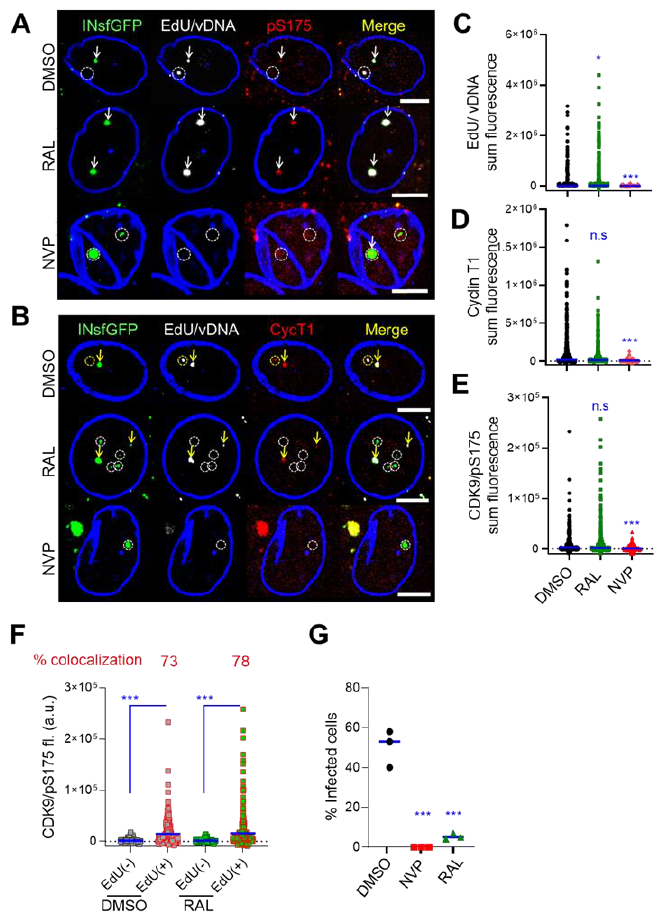
Figure 6. Cellular transcription machinery associates with nuclear HIV-1 clusters. MDMs were pretreated with Vpx( + ) SIV-VLPs and infected with VSV-G-pseudotyped HIV-1 labeled with INsfGFP by spinoculation (MOI of 2). Unbound virus was washed away, EdU (5 µ M) was added, and MDMs were cultured for 72 h. ( A – E ) As indicated, infections were carried out in the presence of nevirapine (NVP, 10 µ M) or raltegravir (RAL, 20 µ M). Cells were fixed and stained for EdU / vDNA and the components of the P-TEFb transcription complex, Cyclin T1 (CycT1) and CDK9 / pS175 (pS175). ( A , B ) Images of MDM nuclei showing INsfGFP fluorescence (green), EdU / vDNA (white), and pS175 ( A ) or CycT1 ( B ) staining (red). Arrows in ( A ) and ( B ) point to the IN spots colocalized with EdU and P-TEFb complex; dashed circles indicate IN clusters that do not colocalize with EdU, P-TEFb, or both. ( C – E ) Analysis of nuclear INsfGFP puncta colocalization with EdU ( C ), Cyclin T1 ( D ), and CDK9 / pS175 ( E ). ( F ) Analysis of CDK9 / pS175 signal in INsfGFP-labeled VRCs that colocalize with (EdU( + )) or do not colocalize (EdU( − )) with EdU signal. ( G ) The fraction of eGFP-expressing infected cells in control (DMSO) or NVP (10 µ M)- or RAL (10 µ M)-treated samples was determined for 3 donors. Scale bar in ( A ) and ( B ) is 5 µ m. Blue lines in ( C – G ) represent SEM and median at 95% CI representative of > 300 nuclear IN puncta from > 50 nuclei ( C – F ) and percentage of infected cells from 3 donors ( G ). p < 0.05 ( ∗ ) was considered significant; ∗∗∗ denote p < 0.001,